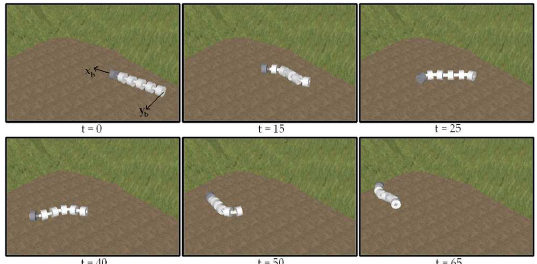
Figure 10: 3D visualization of the simulated gait pat- tern, lateral undulation. 0 < t < 15: